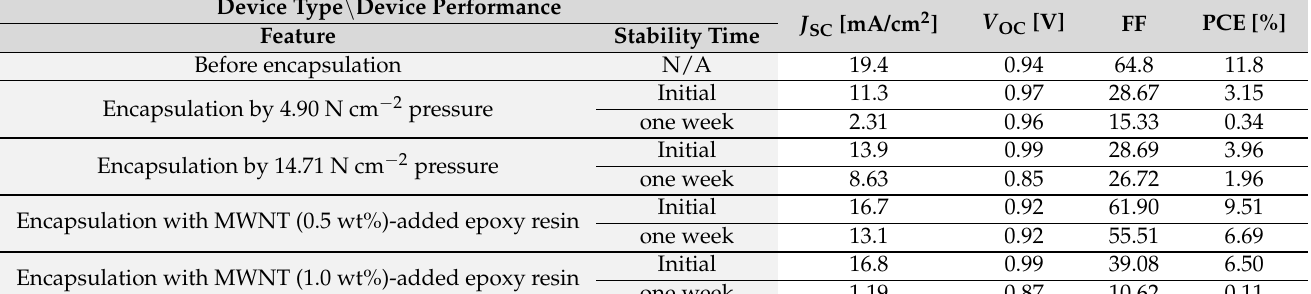
Table 1. Packaging type of the devices and solar cell performance values before and after one week of durability testing. More detailed corresponding J – V curves, EQE, and statistical information can be found in Figures S7, S15 and S16). Device Type \ Device Performance